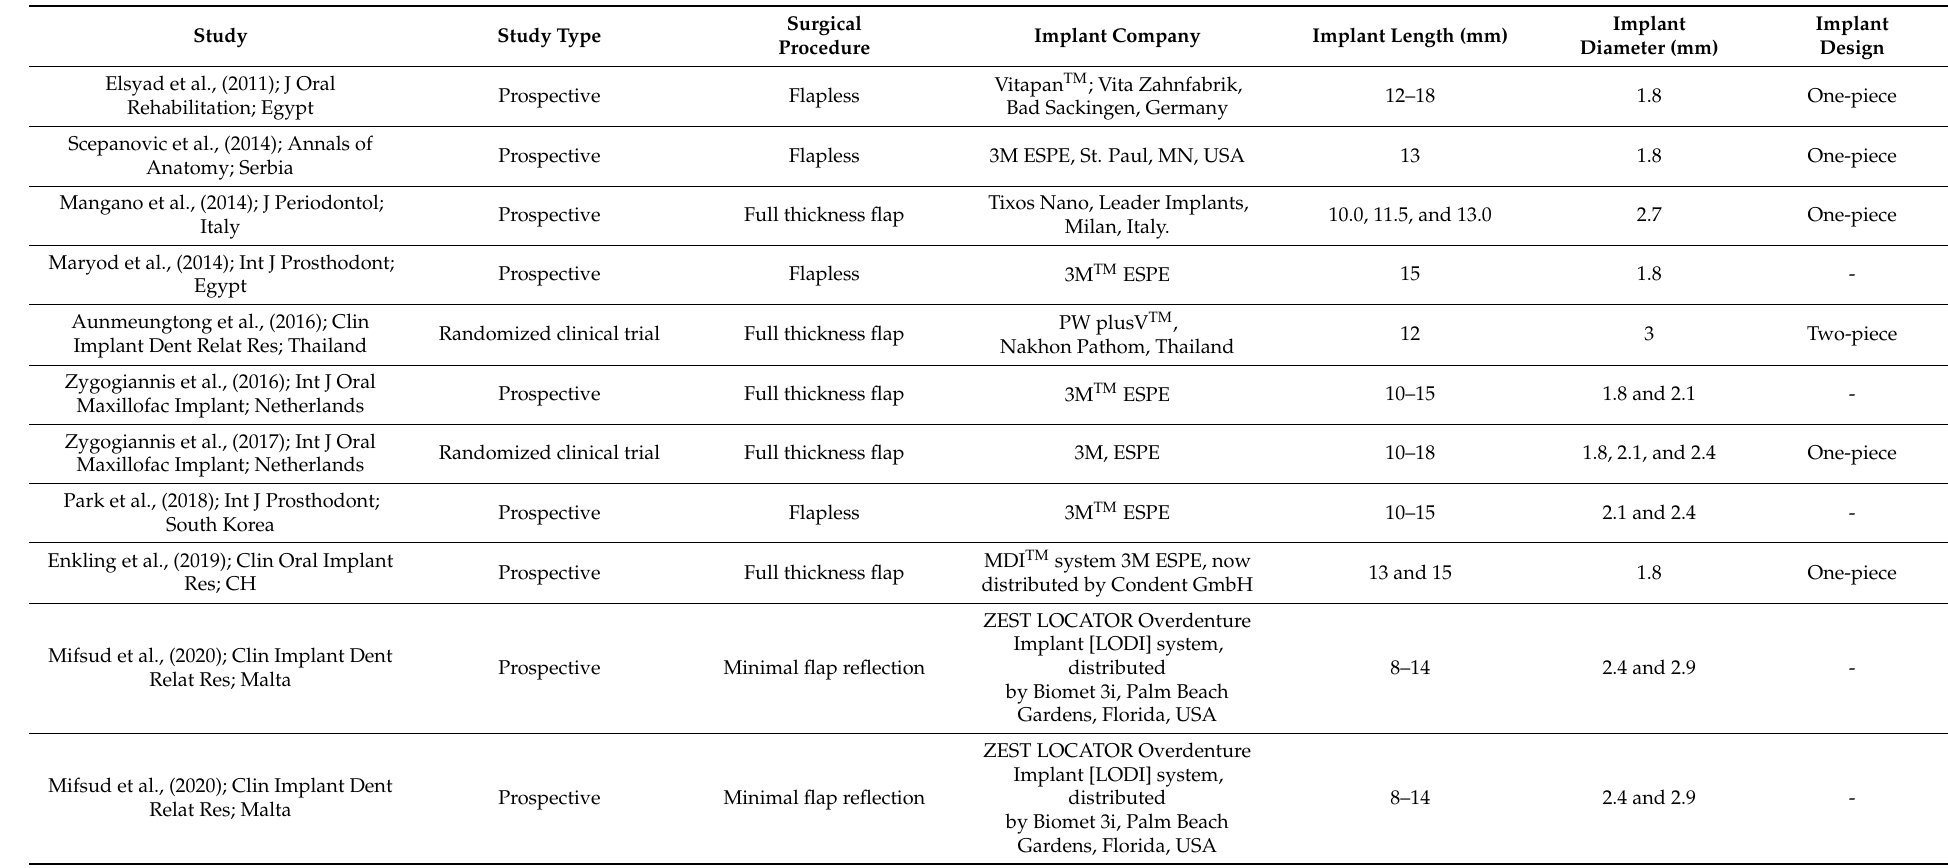
Table 1. Summary of qualitative data of the 11 included articles on immediately loaded mini dental implants to retain mandibular